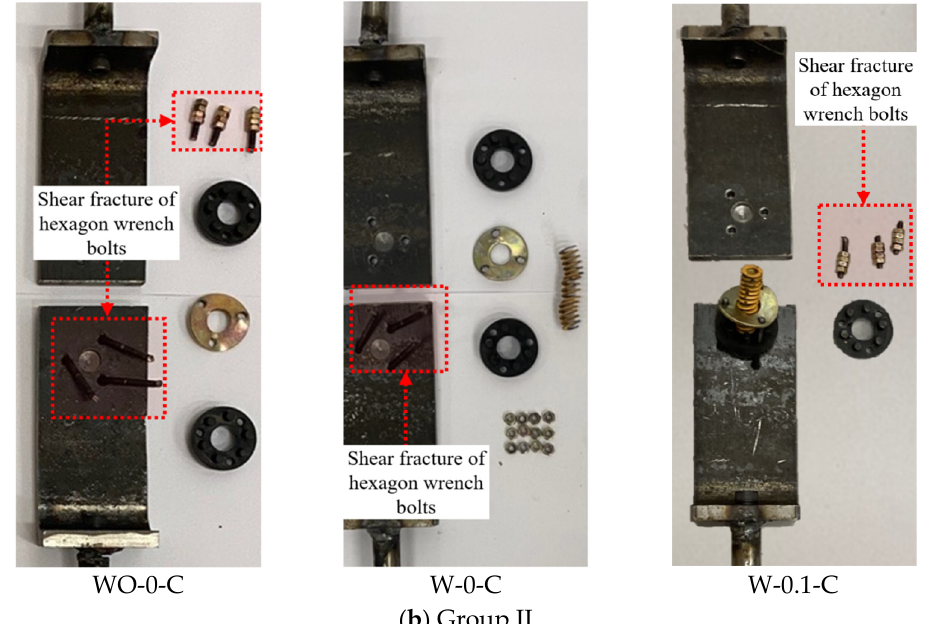
Figure 5. Failure mode of the SDI specimens: ( a ) Group I; ( b ) Group II.